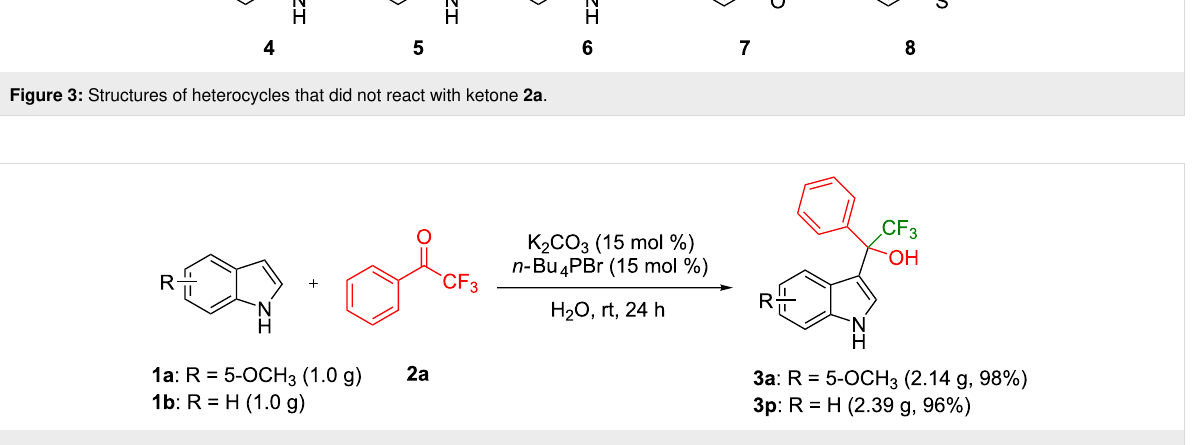
Scheme 1: Gram-scale synthesis of 2,2,2-trifluoro-1-(1 H -indol-3-yl)-1-phenylethan-1-ols ( 3a and 3p